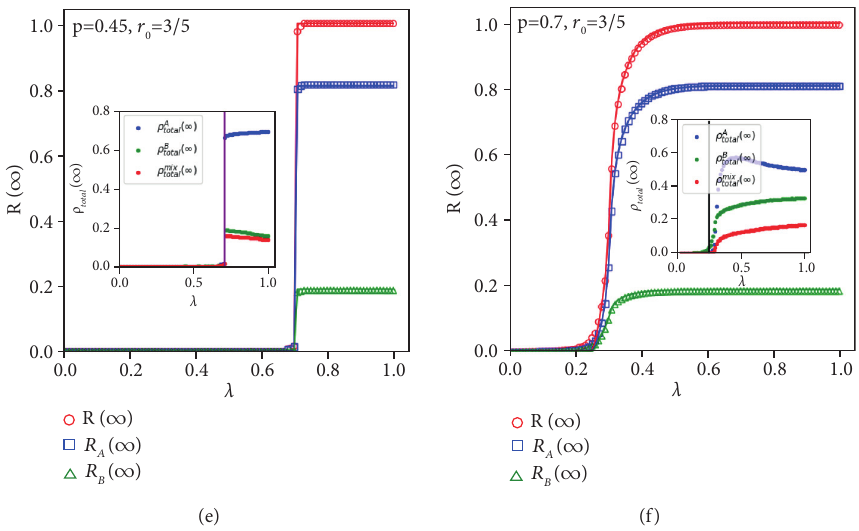
Figure 3: The change of spreading size (R) ( ∞ ) with the increase of λ . The red circle represents the proportion (R) ( ∞ ) of the adoption size of individuals, the blue square represents the proportion R A ( ∞ ) of the adoption size of type-A individuals, and the green triangle represents � 1/5, p � 0 . 45, 0 . 7 , 0 . 9 and 0 . 975, the adoption size the proportion R B ( ∞ ) of the adoption size of type-B individuals. (a–d) when r 0 � 3/5, p � 0 . 45 , 0 . 7, the adoption size changes with the increase of λ . Symbols represent changes with the increase of λ . (e–f) when r 0 simulation results and curves represent theoretical numerical results, which are calculated by equations (10), (11), (22), and (23). The insets show the changes of the proportion of adopted individuals affected only by type-A individuals (blue point) and only by type-B individuals (green point) and the proportion of adopted individuals affected by the two types of individuals together (red point). The vertical black lines represent λ � λ II c , the vertical orange lines represent λ � λ s , and the vertical purple lines represent λ � λ I c . Other parameters: N �